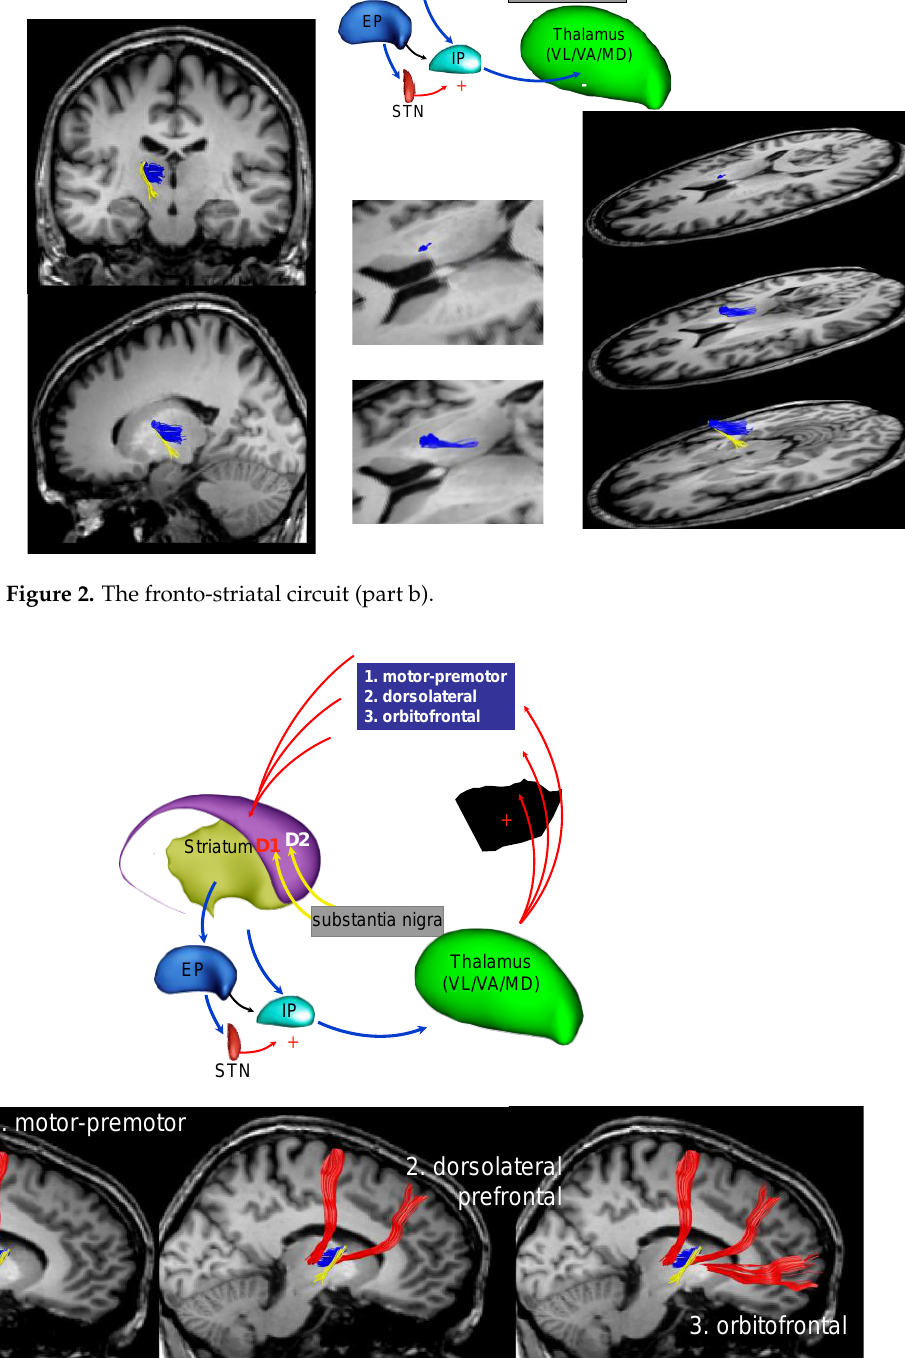
Figure 3. The fronto-striatal circuit (part c).